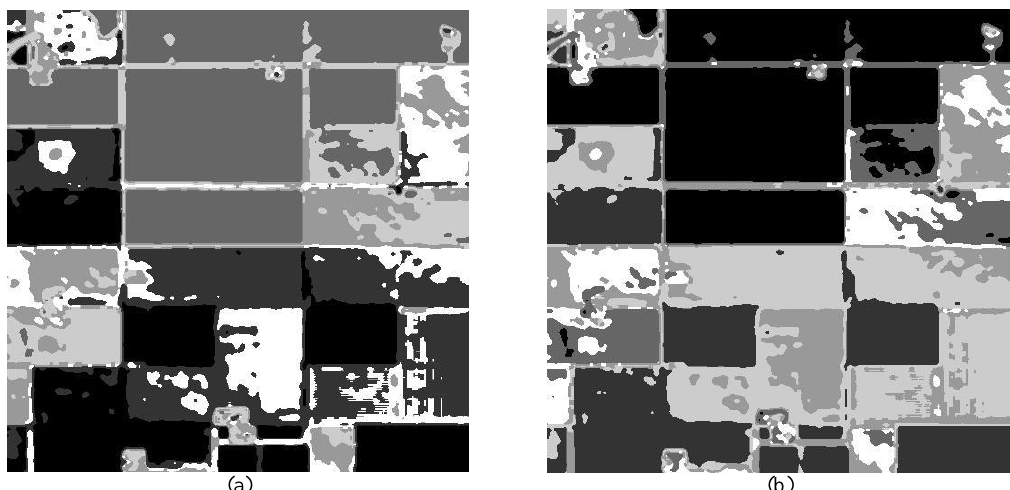
Figure 6. Result of segmentation. (a) FCM clustering with 7 × 7 windowsize (b) k-means clustering 7 × 7 windowsize